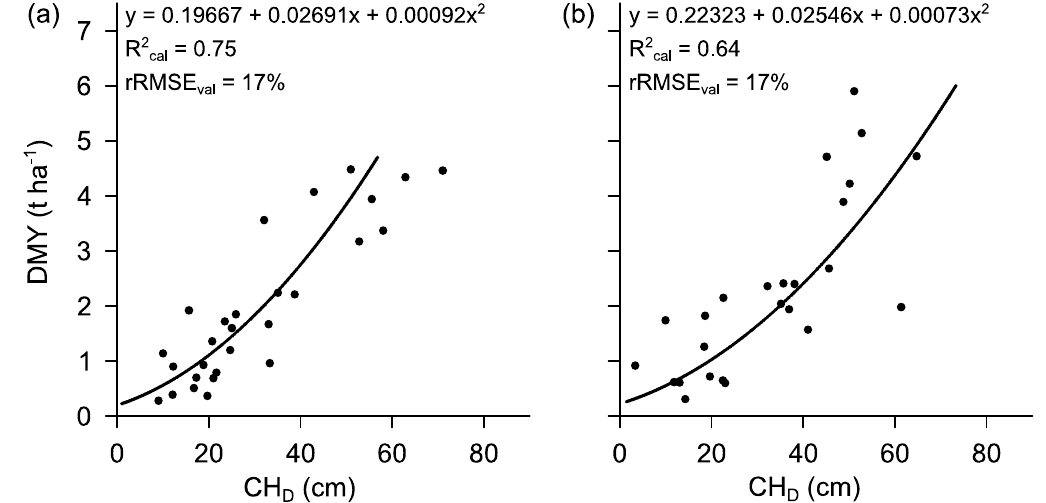
Figure 5. Legume-specific regression models of the calibration dataset with validation dataset ( ) for dry matter yield (DMY) based on canopy height from UAV-based RGB imaging (CH D ). For better understanding DMY data was re-transformed to the original scale. Models for clover-grass ( a ) and lucerne-grass ( b ) both include the respective mixtures as well as the corresponding pure legume and grass swards. R 2 = coefficient of determination; rRMSE = relative root mean square error (calculated with square root-transformed data). Table 4. Linear regression analysis of calibration (cal) and validation (val) dataset between dry matter yield and manual height measurements (CH R ) as well as UAV-based RGB imaging (CH D ) for clover-grass (CG) and lucerne-grass (LG) mixtures including corresponding pure stands of legumes (L) and grass swards (G). n = number of samples; R 2 = coefficient of determination; RMSE = root mean square error; rRMSE = relative RMSE; d = Willmott’s refined index of agreement.